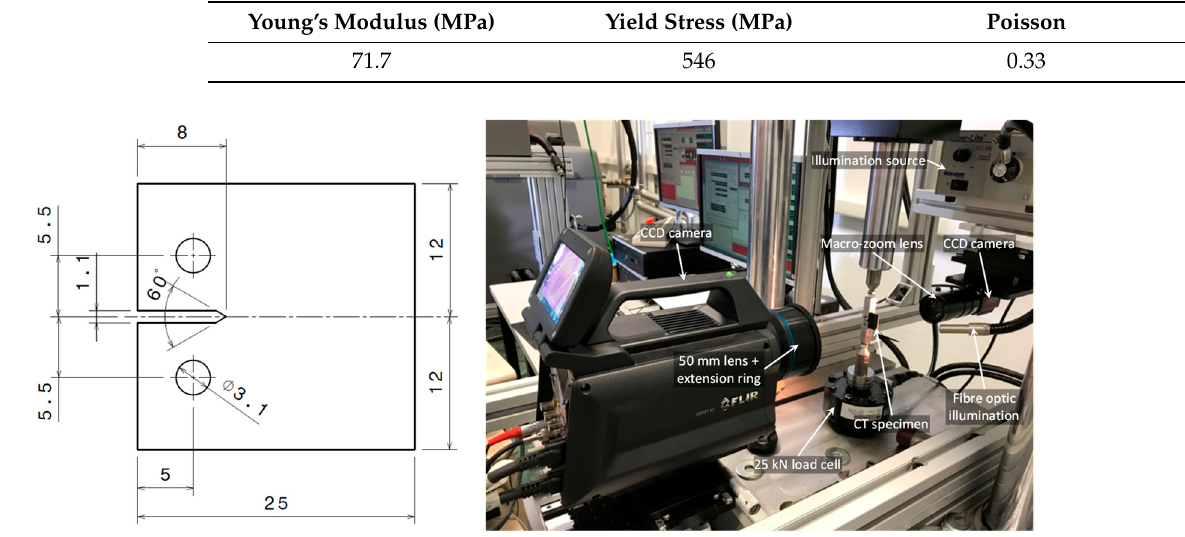
Table 1. Mechanical properties for aluminium 7050-T6.